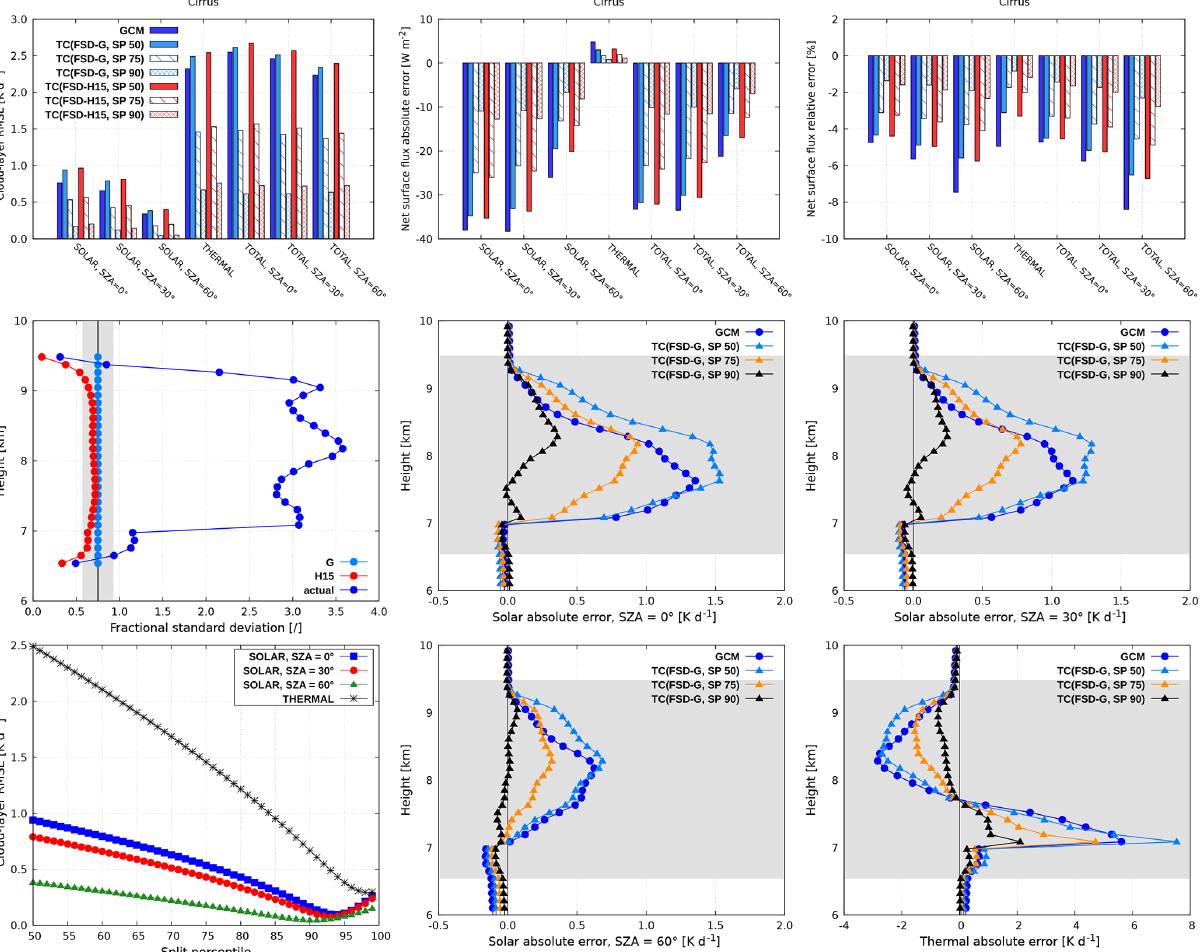
Figure 10. Optimizations for cirrus (subgrid variability is modeled lognormally in all TC experiments shown).